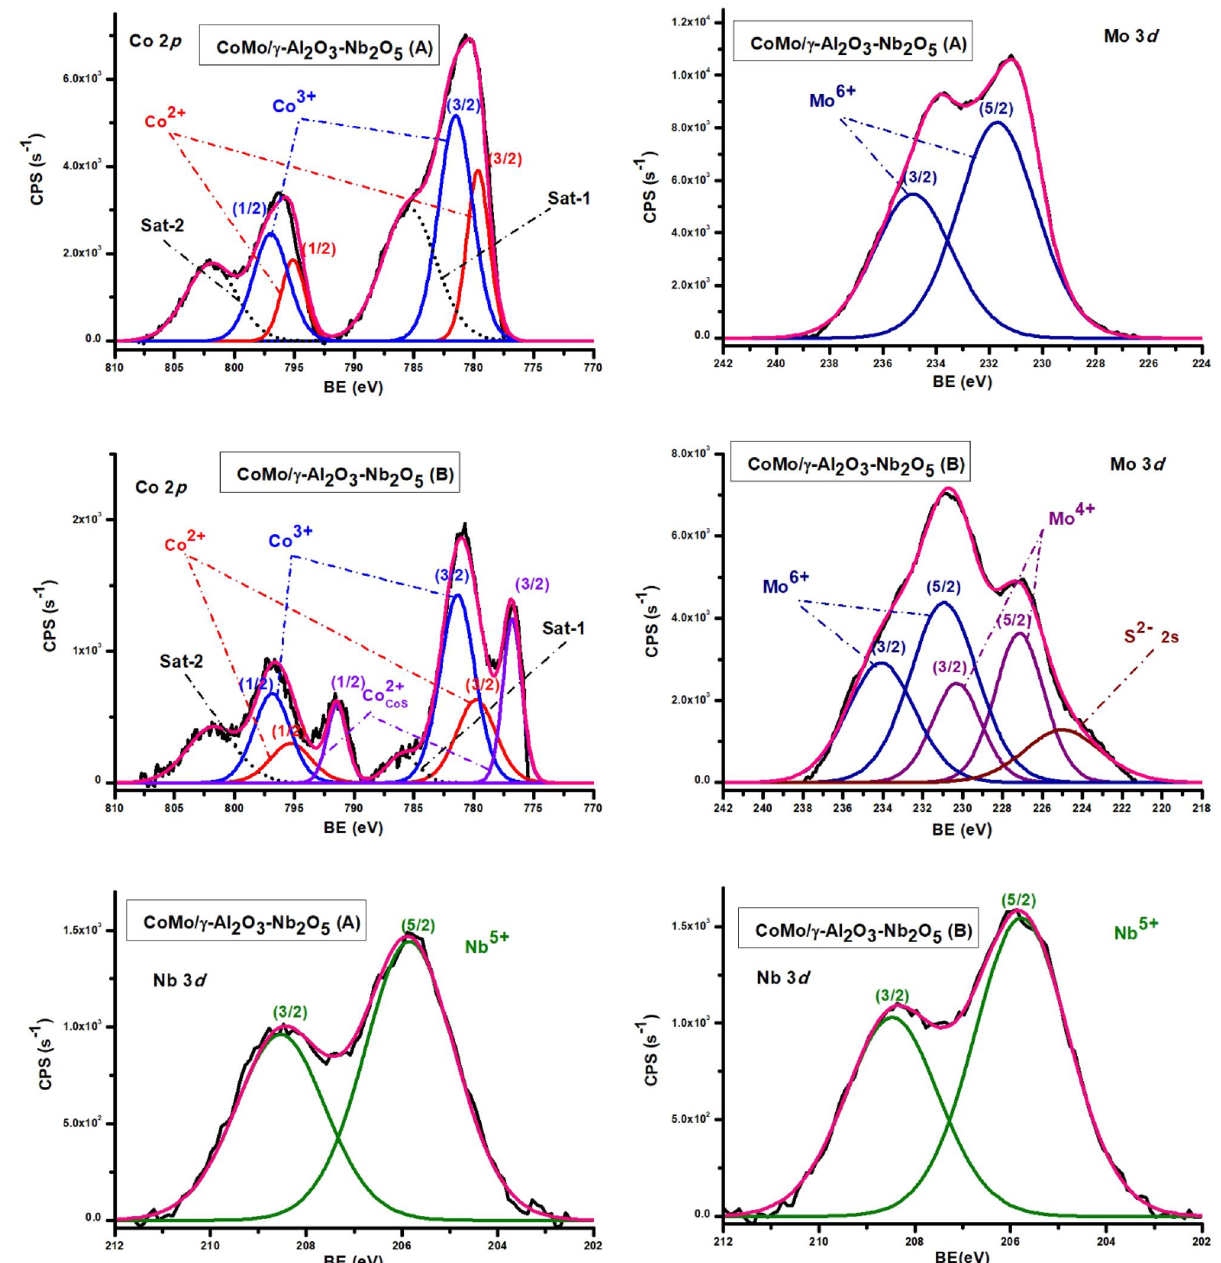
Figure 8. The XPS spectra of CoMo/γ-Al 2 O 3 -Nb 2 O 5 catalyst before and